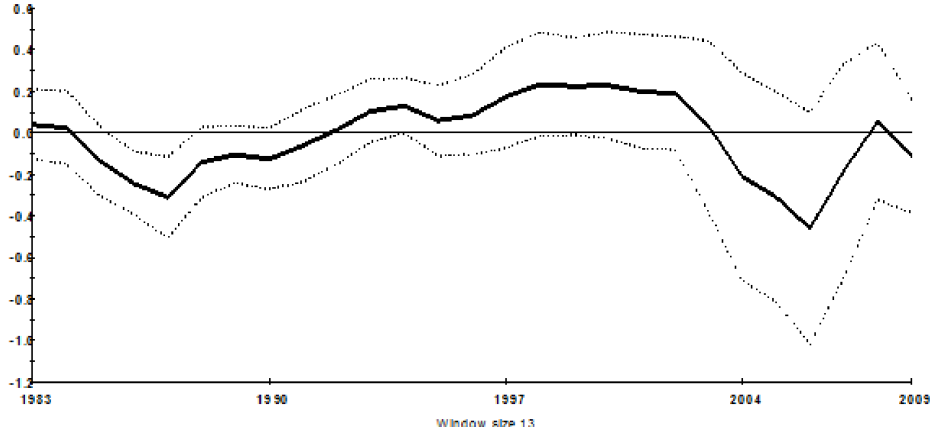
Fig 2. Coefficient of Ln (TOI) and its two* S.E. bands based on rolling OLS Note: dependent variable: Ln(Y); total no. of regressors: